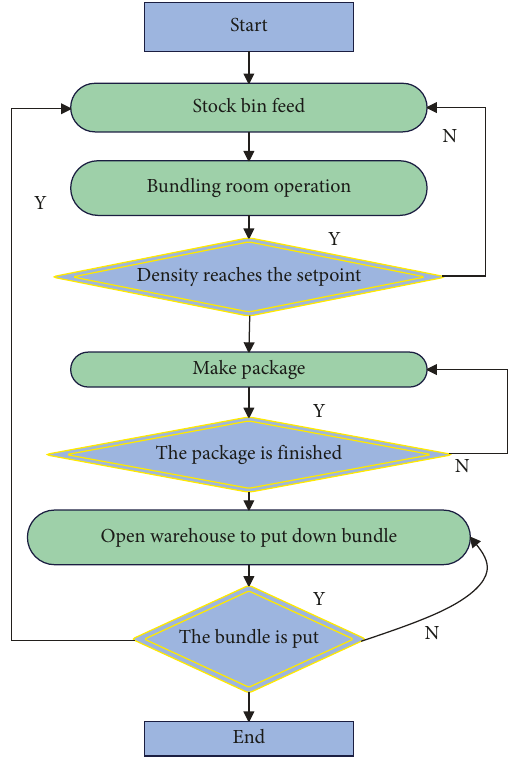
Figure 6: Operation flowchart of the baling device.